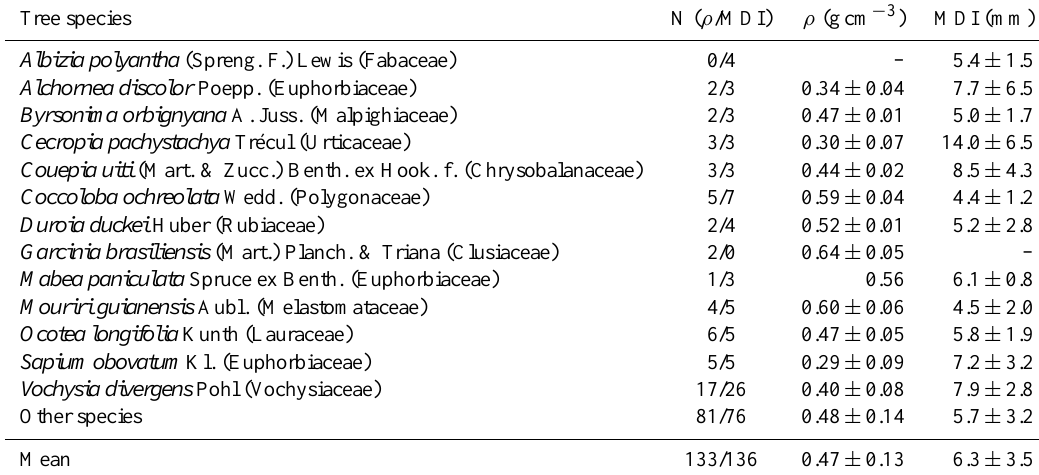
Table 2. Wood density ρ and mean diameter increment (MDI) rates of characteristic tree species in the Pantanal (Arruda, 2006). Tree